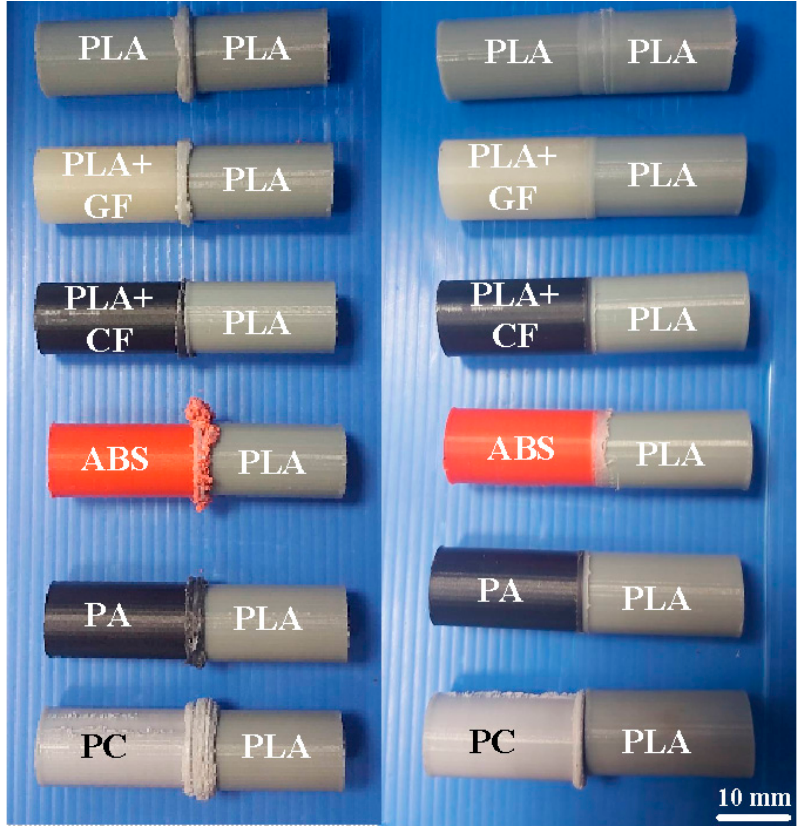
Figure 7. Results of FRW of dissimilar polymer rods.